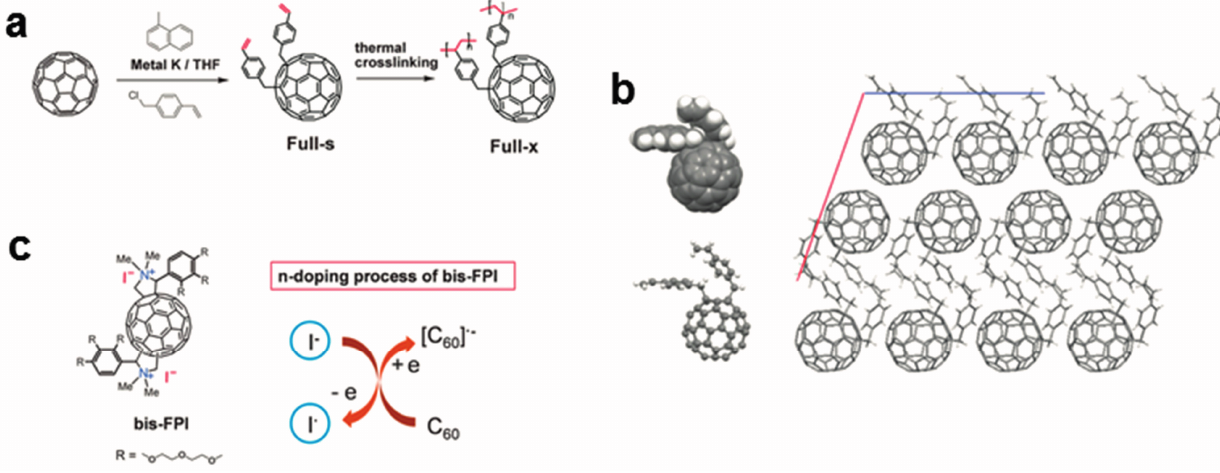
Figure 11. ( a ) The synthetic route to Full-s and thermally cross-linked Full-x; ( b ) the single crystal analysis of Full-s. Molecular packing of Full-s suggests that fullerene and vinylbenzyl groups pack in a crystalline phase; ( c ) the chemical structure of bis-FPI and the doping mechanism through an anion-induced electron transfer process. Reprinted with permission from [88]. Copyright 2014 Royal Society of